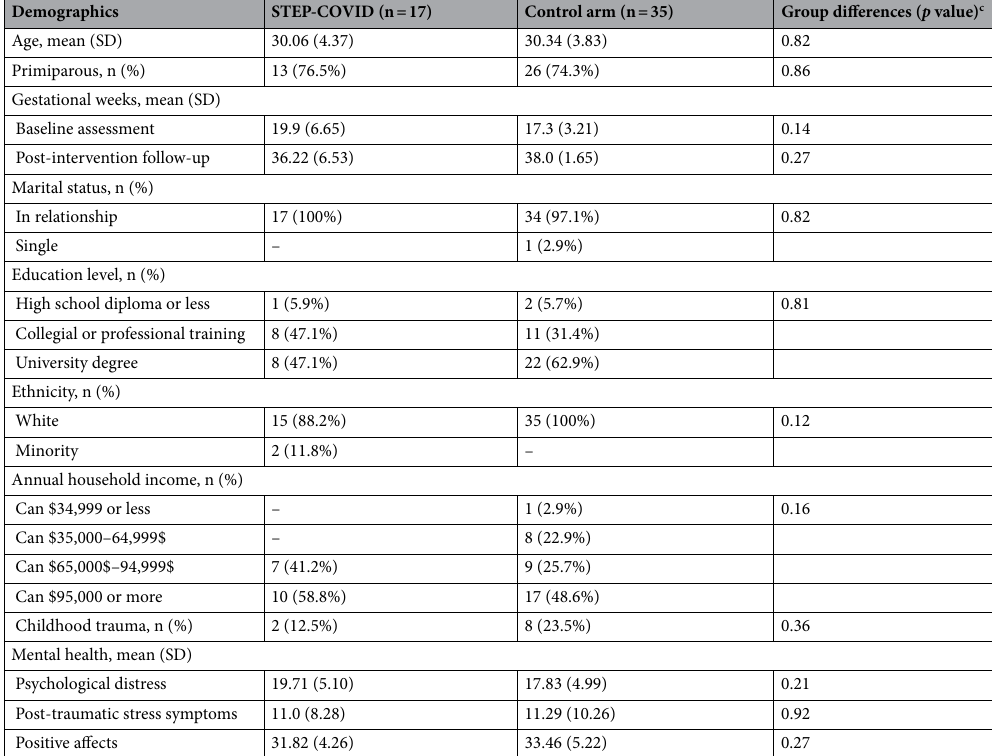
Table 2. Baseline participant characteristics of women who provided complete post data (n = 52). c Two-sided p -values were obtained from t -tests for continuous variables and Chi-square tests for categorical